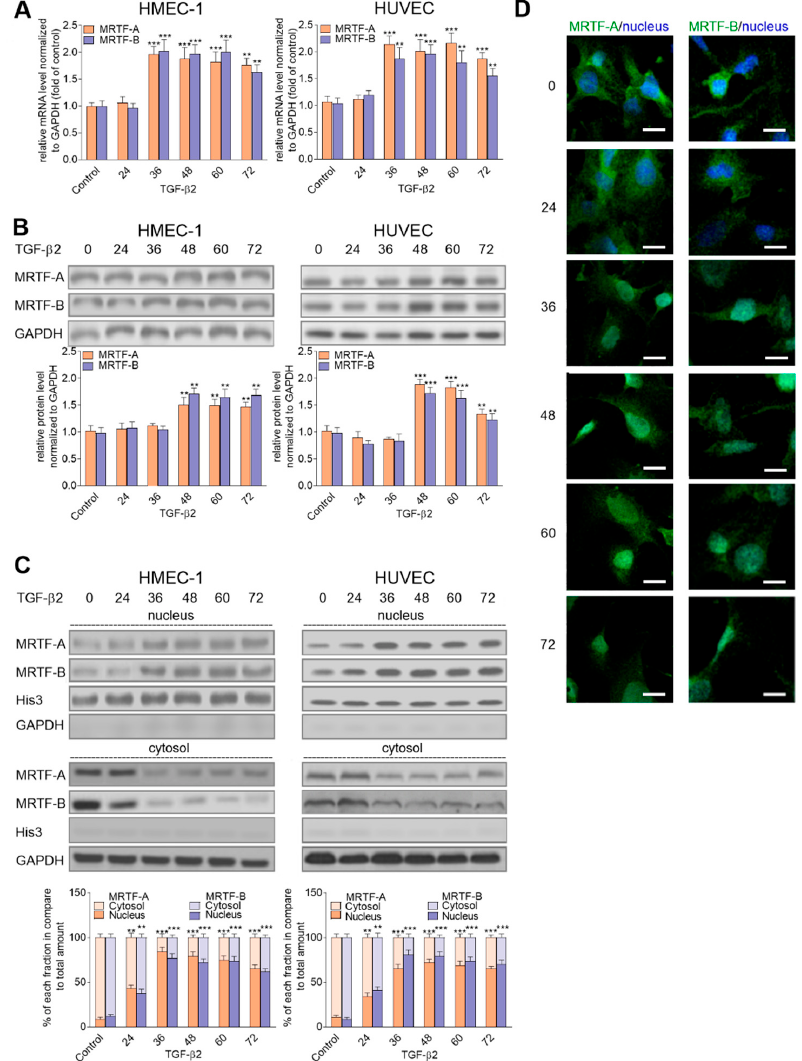
Figure 2. TGF- β 2-induced myocardin-related transcription factor (MRTF) upregulation affected their nucleus accumulation. HMEC-1 cells and HUVECs were incubated with TGF- β 2 (10 ng / mL) for 24, 36, 48, 60, and 72 h, or alone. Subsequently, ( A ) expression of MRTF-A and MRTF-B was analyzed by real-time PCR. The protein levels of the MRTFs were determined by Western blot analysis in ( B ) total lysate and ( C ) the nucleus and cytoplasm fraction of the analyzed cells. The background was subtracted and the area for each protein peak was determined. In the analysis of the MRTFs, the translocation MRTF-A or -B level was determined as a % of the total MRTF-A or –B. Protein levels were normalized to GAPDH (total lysate or cytoplasm fraction) or His3 (nuclear fraction). Blots are representative of three independent experiments. ( D ) The localization of MRTF-A and MRTF-B in the cellular compartments were analyzed using a confocal microscope. MRTFs were stained with antibodies conjugated with FITC. The white bar represents a 30 µ m length. Representative images are shown. The results are presented as the means ± SD ( N ≥ 3); ** p < 0.01, *** p <